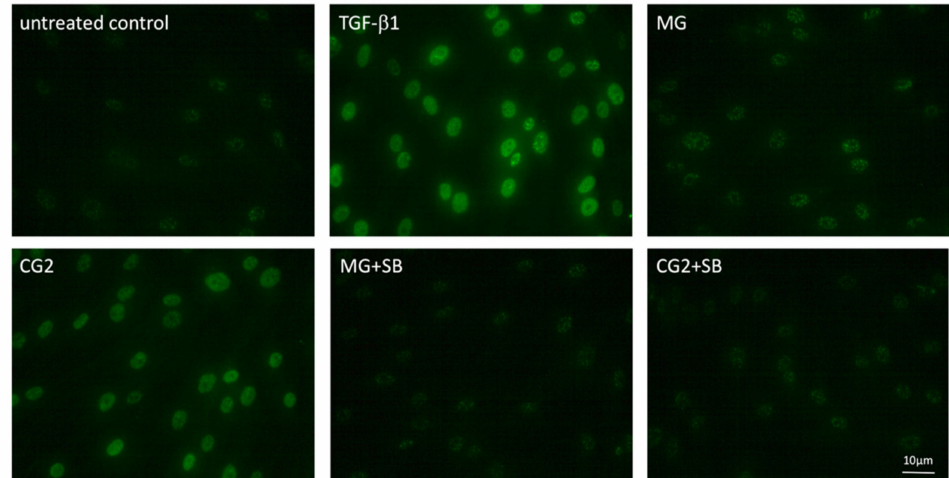
Figure 6. Phosphorylated smad3 nuclear translocation by MG and CG2 being blocked by SB431542.